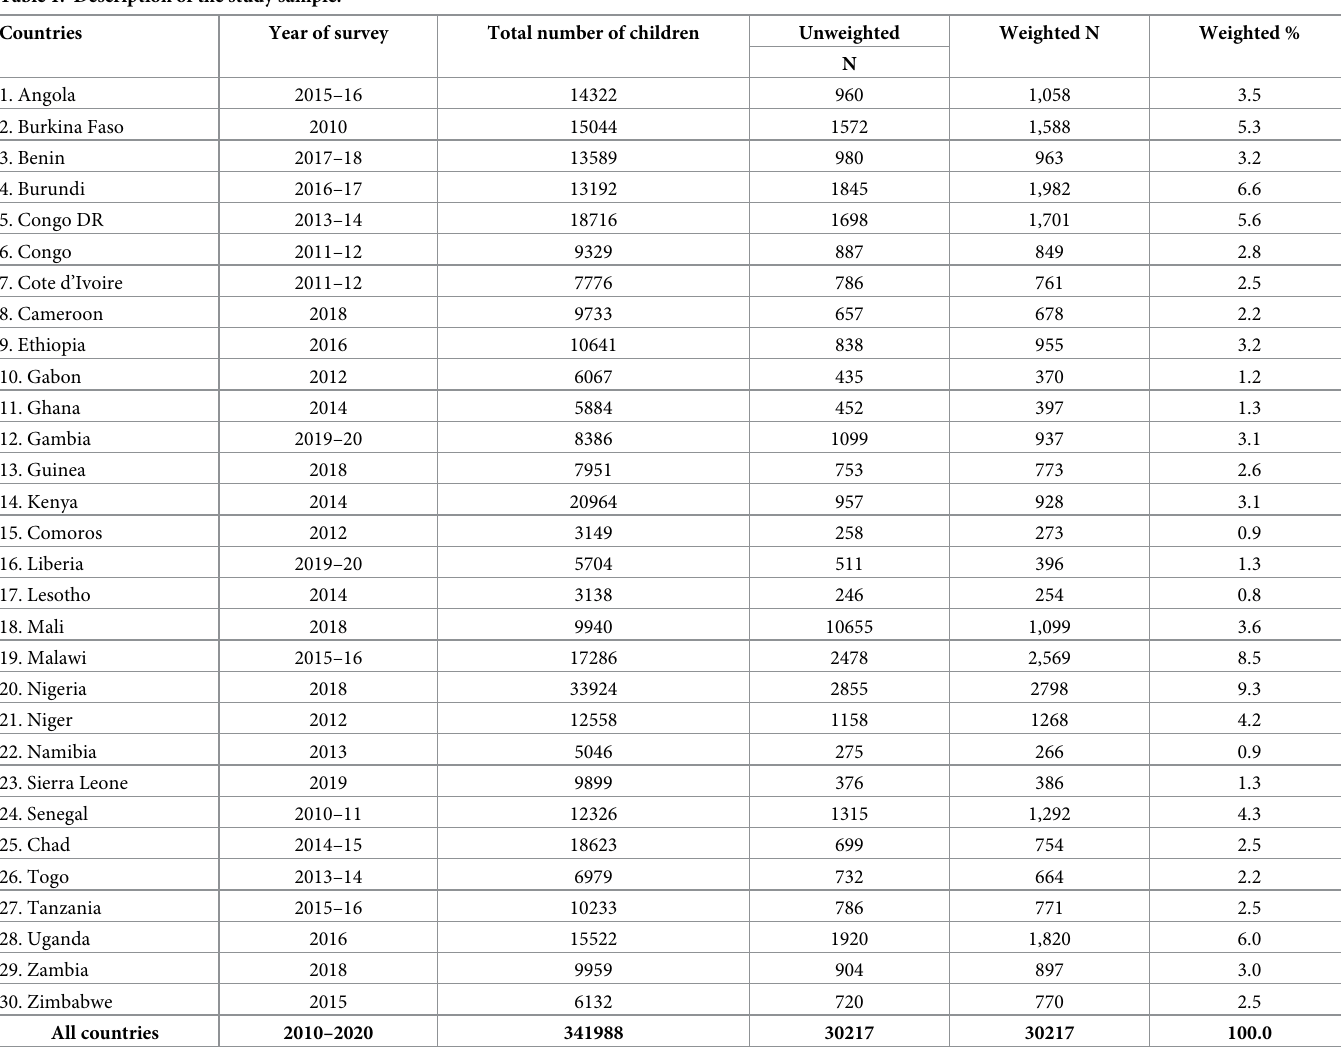
Table 1. Description of the study